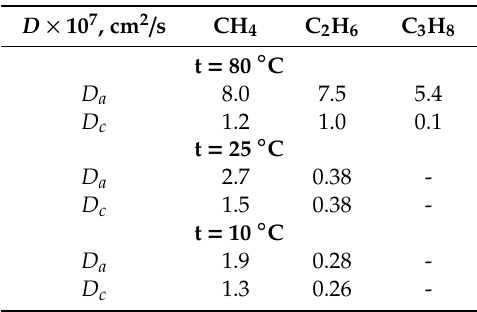
Table 3. The gas di ff usion coe ffi cients in the amorphous and crystalline phases of PMPentene at di ff erent